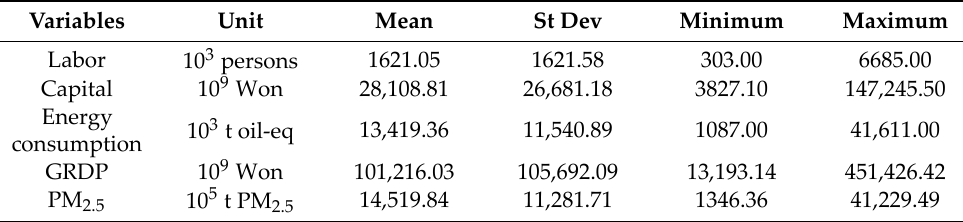
Table 3. Descriptive statistics of input and output variables,